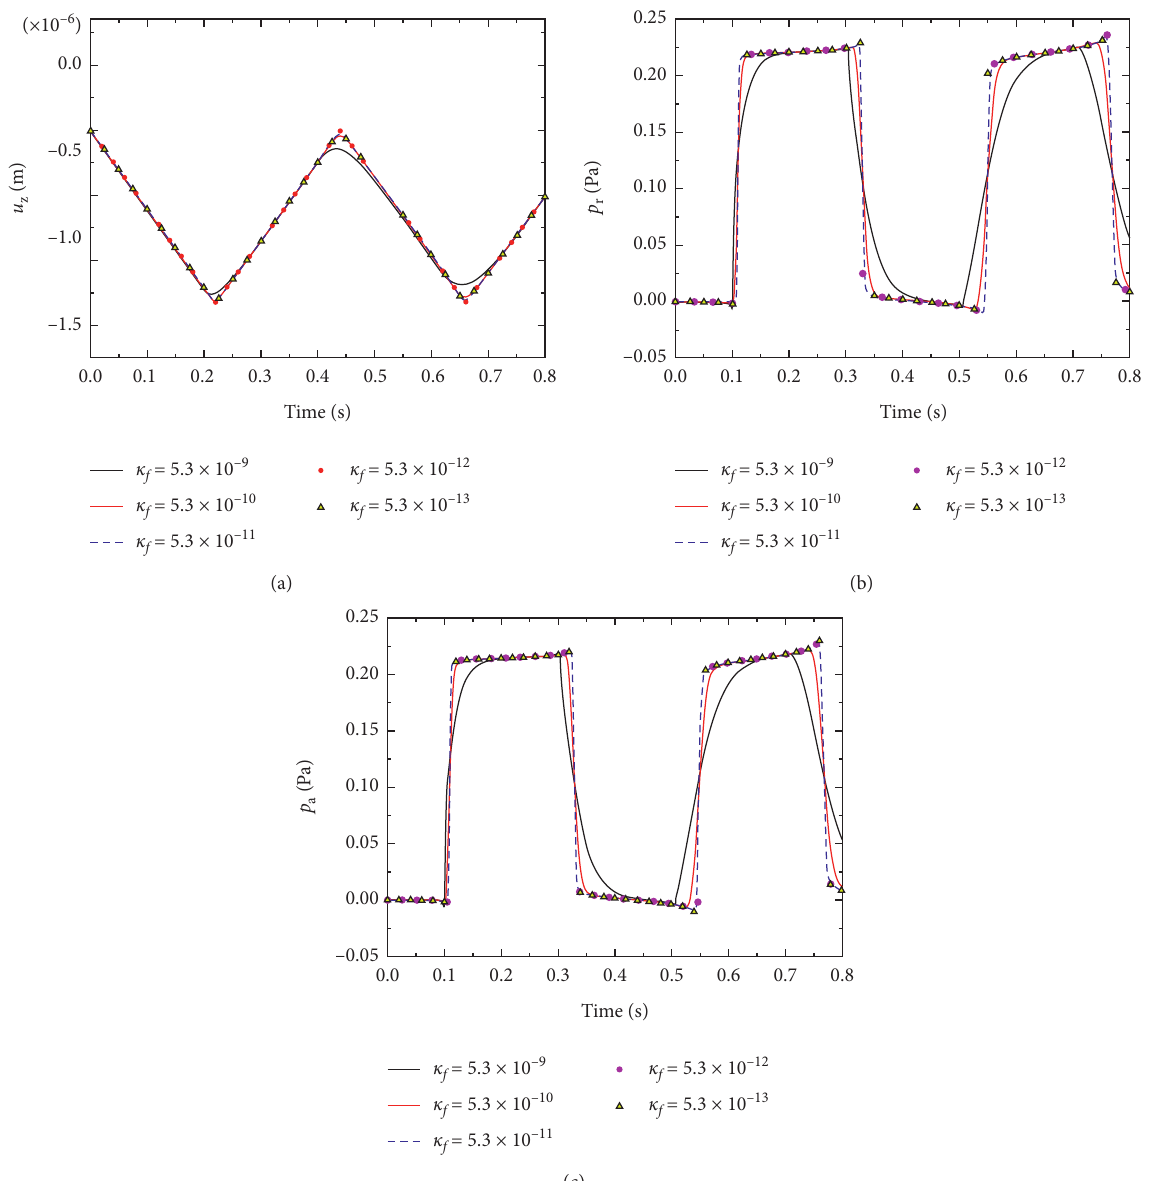
Figure 6: Distributions of the displacement of solid particles u using different fluid permeability values ( κ f � 5.3 × 10 − 9 to 5.3 × 10 − 13 ). (a) u z . (b) p f . (c) p a